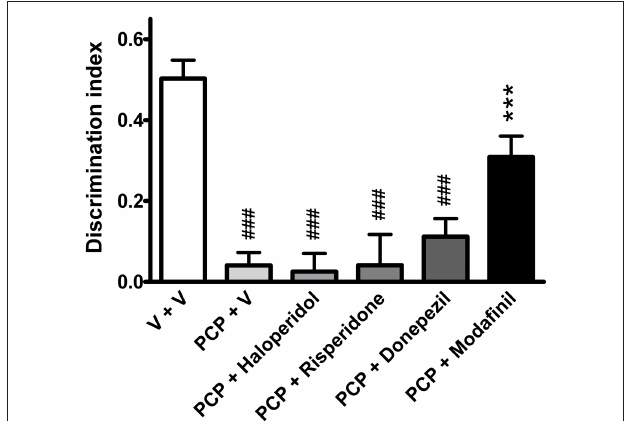
)/( T ) in the NOr task in rats − T + T n f n f